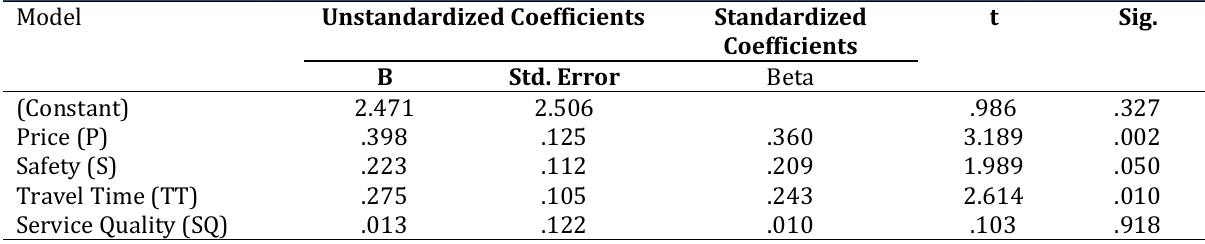
Table 2: Multiple regression of railway commuting factors and customer patronage